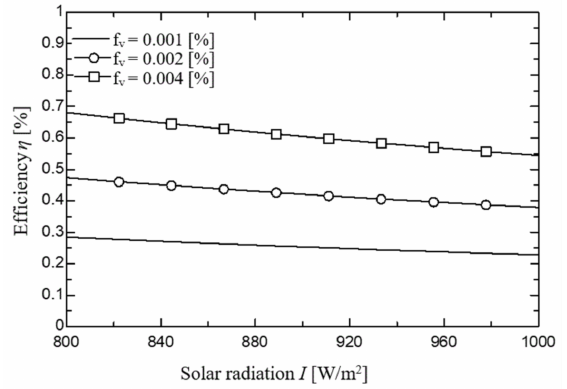
Figure 3. Analysis of the efficiency of the LTSC with increasing solar